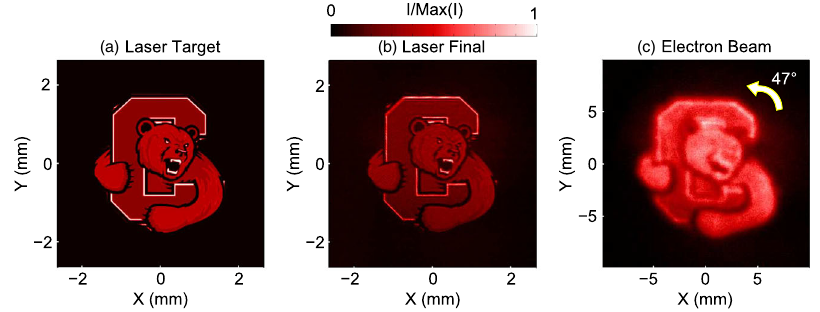
FIG. 6. (a) Laser target (see text for details). (b) Final measured laser distribution. (c) Resultant beam distribution, rotated by 47 degrees in after acquisition, with no median